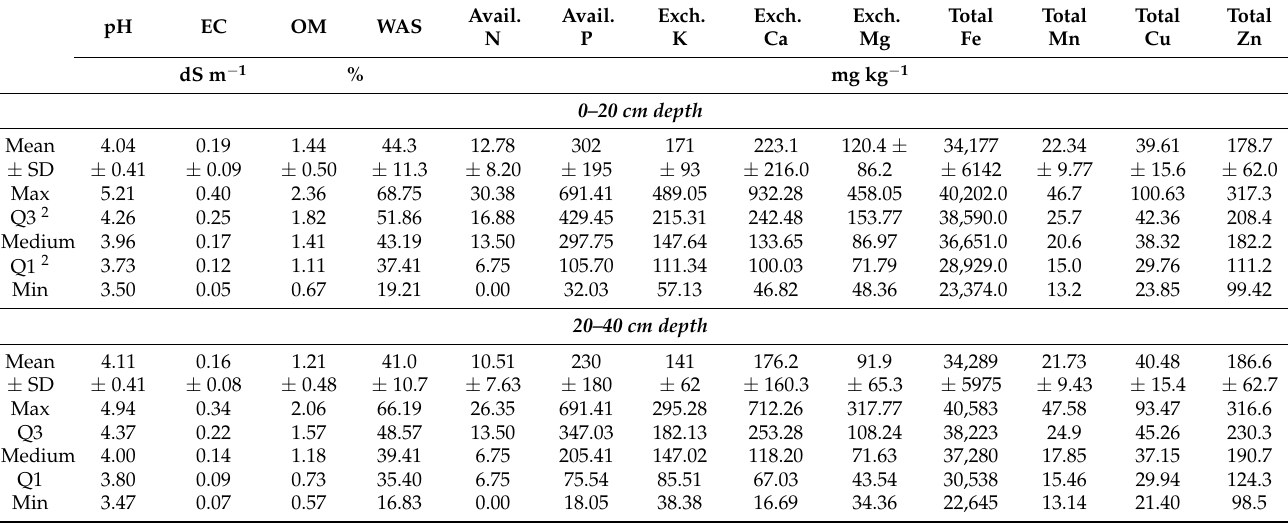
Table 1. The basic descriptive statistics of soil properties 1 . (n =